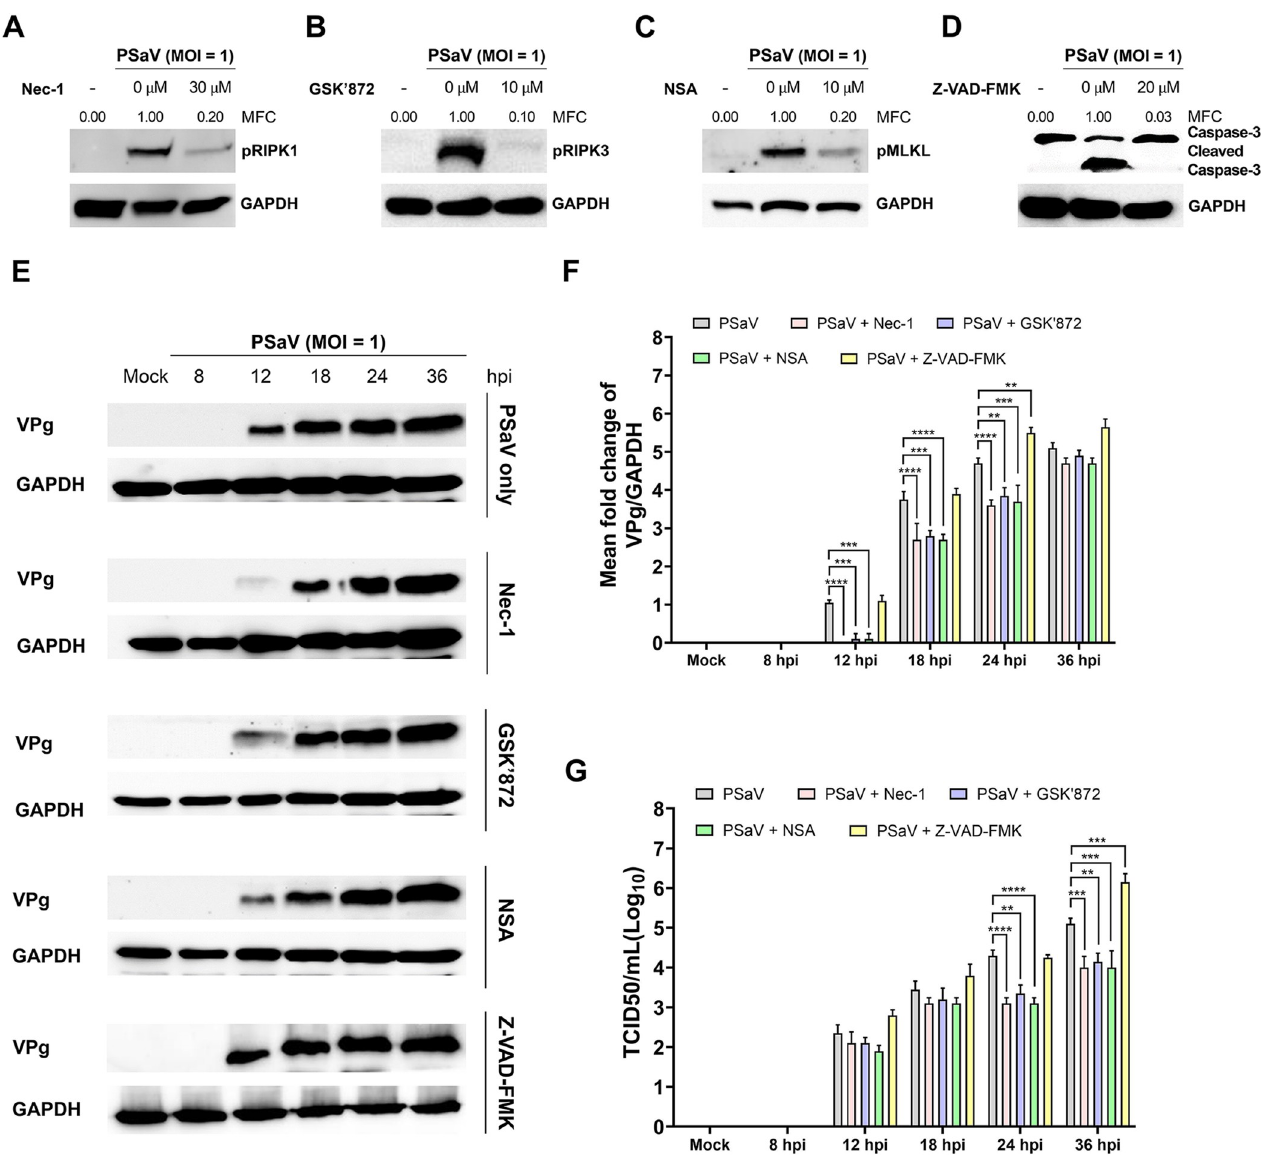
Fig 6. Blocking the necrosome formation or apoptosis in LLC-PK cells inhibits or activates PSaV replication, respectively. LLC-PK cells were infected with PSaV Cowden strain (MOI = 1 TCID 50 ) for 1 h and then incubated with a maintenance medium containing 200 μ M GCDCA with 30 μ M Nec-1 (RIPK1 inhibitor), 10 μ M GSK’872 (RIPK3 inhibitor), 10 μ M NSA (MLKL inhibitor), or 20 μ M Z-VAD-FMK (pan-caspase inhibitor). (A-D) The cell lysates were harvested at 24 hpi and the expression levels of pRIPK1, pRIPK3, pMLKL, and cleaved caspase 3 were evaluated by western blotting. (E) The cell lysates at the indicated time points were subjected to western blotting to determine PSaV VPg protein. GAPDH was used as a loading control. (F) The relative expression of PSaV VPg in chemical-treated and virus-infected cells compared to that in mock-treated and virus-infected cells (in panel E) was determined via densitometric analysis. (G) The viral titer was determined using the TCID 50 assay and compared with that in the mock-treated and virus-infected cells. Data in panels F and G are presented as the mean ± standard errors from two independent experiments. Differences were evaluated using two - way ANOVA. �� p < 0.01; ��� p < 0.001; ���� p <